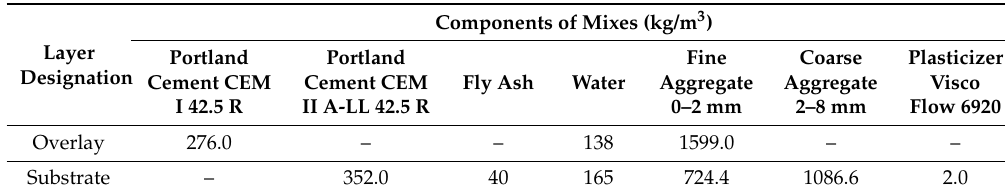
Figure 2. Exemplary view of tests carried out on the surface of the overlay using: ( a ) the IR method; Figure 1. The tested two ‐ layer cement composite: ( a ) arrangement of testing areas on the surface of ( b ) the I ‐ E method; and ( c ) the pull ‐ off method. the overlay; ( b ) cross ‐ section; and ( c ) view of the surface of the overlay after pull ‐ off testing.